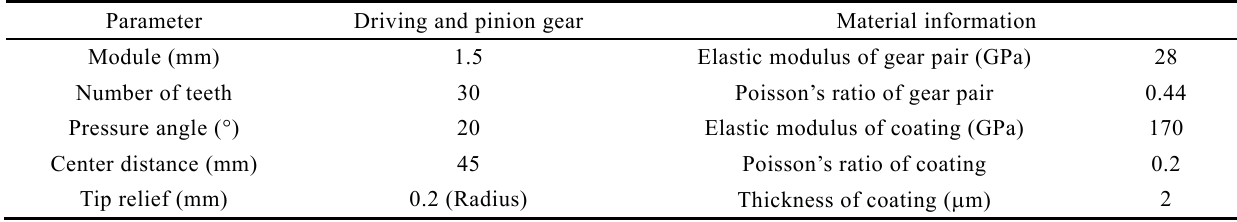
Table 1 Geometric parameters of the involute spur gear and material information.